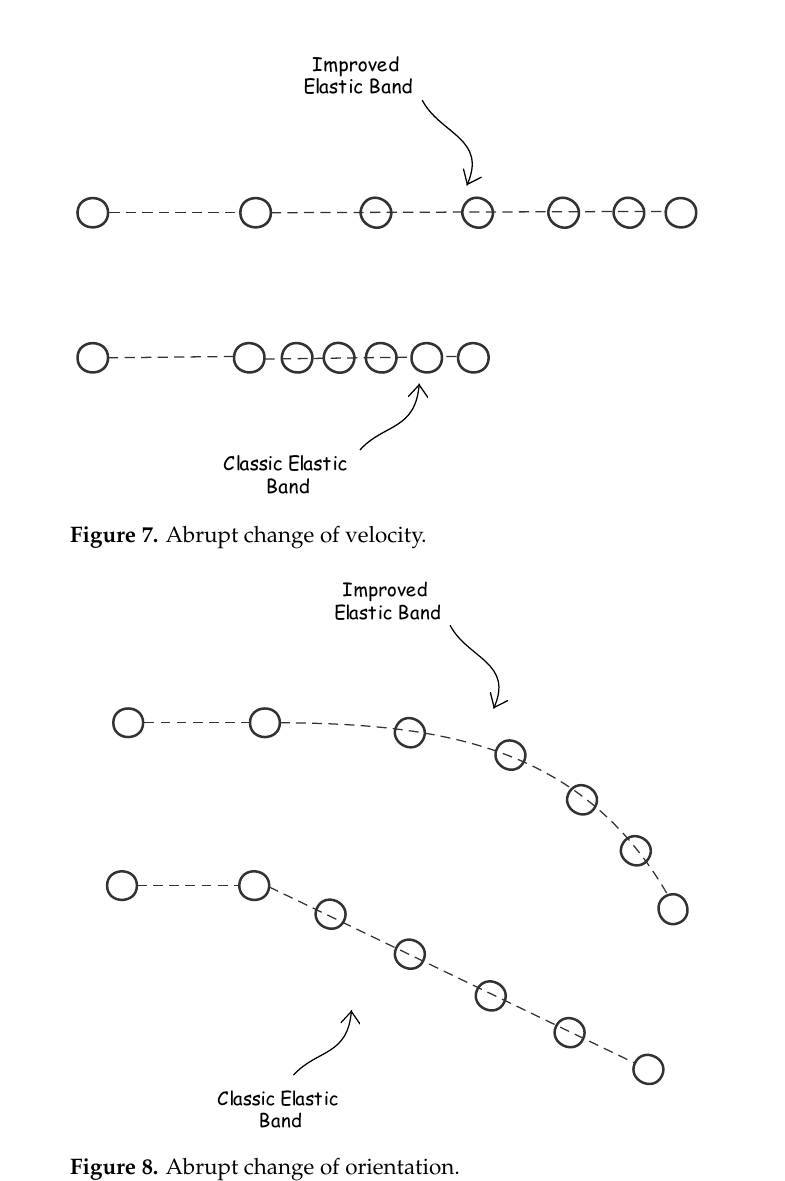
Figure 8. Abrupt change of